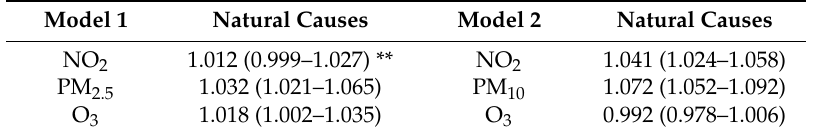
Table 2. Long-term risk for mortality in 2012 associated with air pollution * exposure in 1999–2000 in the French ESPS